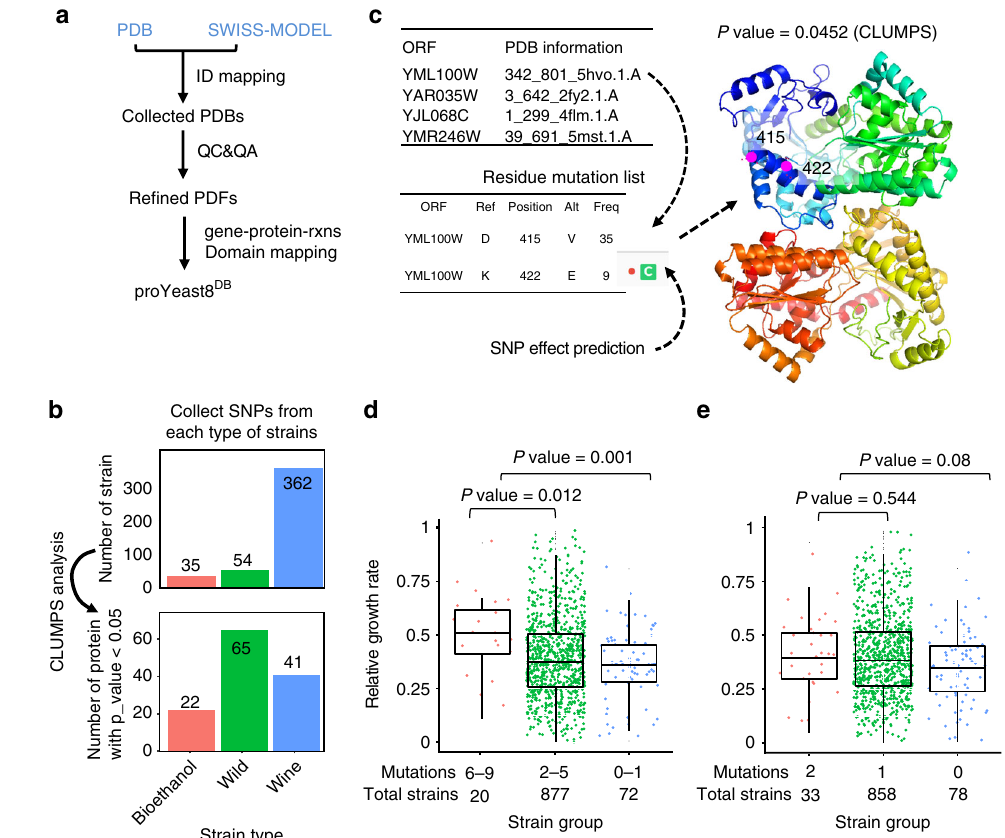
Fig. 4 proYeast8 DB — connects protein 3D structures with yeast GEM and enables the SNP mapping analysis based on protein structures. a Overview of proYeast8 DB formulation. b CLUMPS analysis to fi nd proteins with signi fi cant mutation enrichment 45 . c Function annotation of residue mutation from YML100W and mapping those mutations onto the protein structure. The ‘ C ’ means the related residue mutation is located on the conservative zone of proteins based on the function annotation. d Classi fi cation of strains based on residue mutations in proteins encoded by YML100W, YAR035W, YJL068C and YMR246W. e Classi fi cation of strains based on residue mutations from only one protein encoded by YML100W. The statistical analysis is based